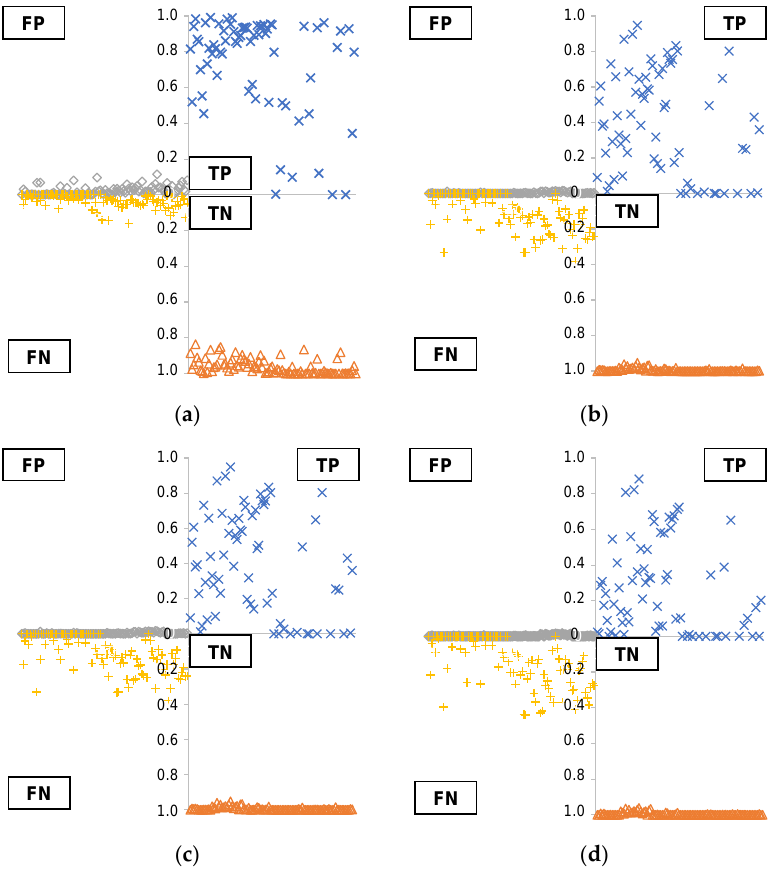
Figure 8. Confusion matrices of the model: (thresholding with 50% and above) ( a ) and with thresholding approaches of 80 % ( b ), 90% ( c ), and 95% ( d ) (x and y axes indicate sample image number of test dataset and percentages of each matrix, respectively).